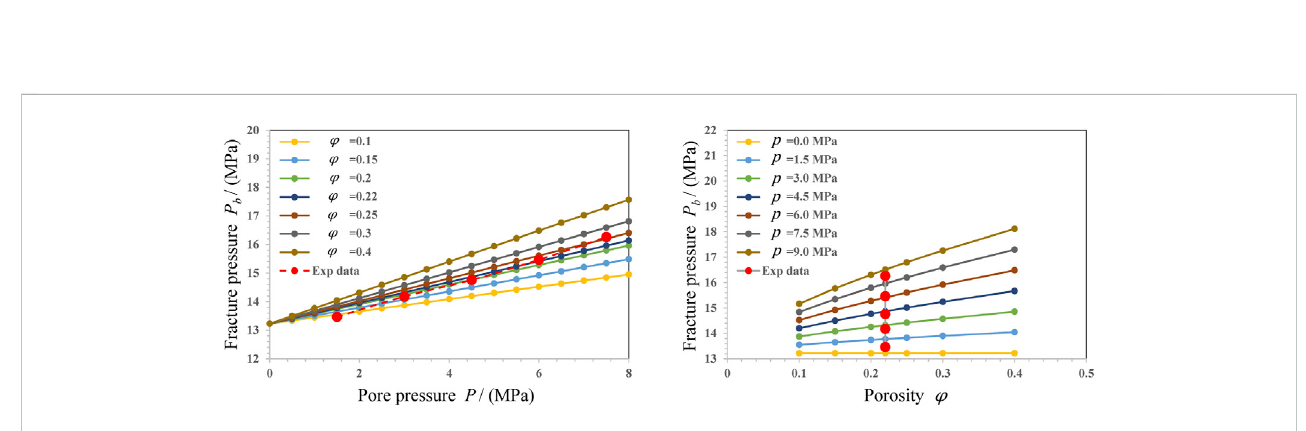
FIGURE 9 In fl uence regularity of the rock porosity φ on the fracture pressure P b .